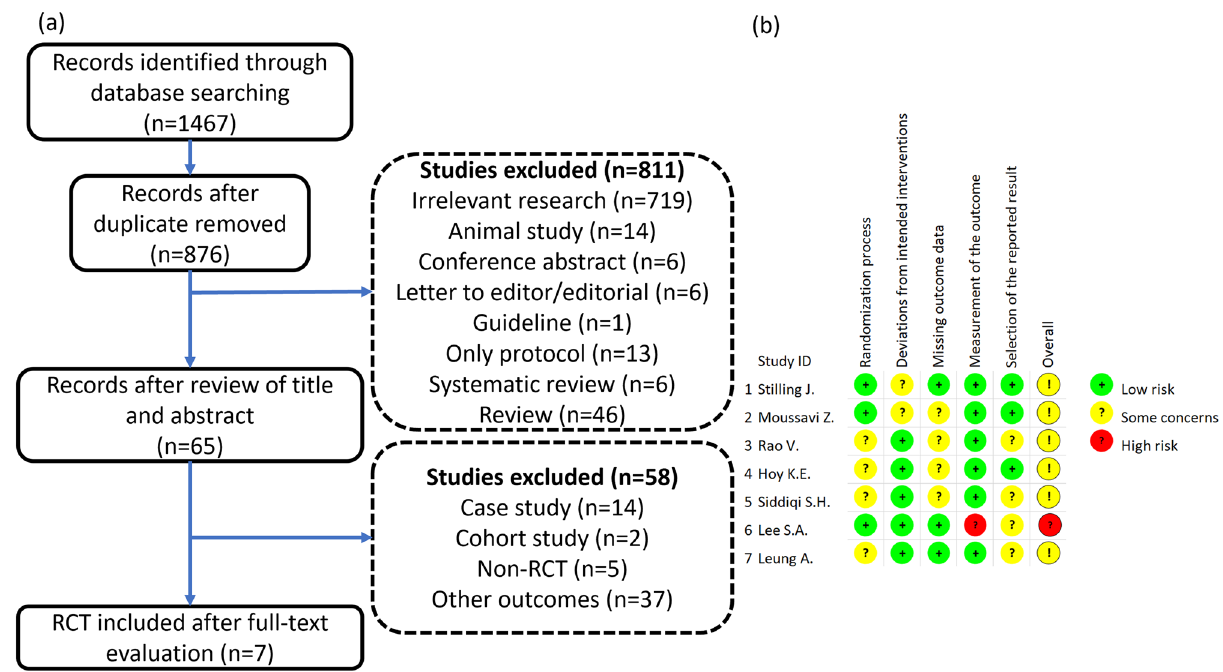
Figure 1. Flowchart of study selection and risk of bias of included studies. ( a ) Flowchart and ( b ) risk of bias.